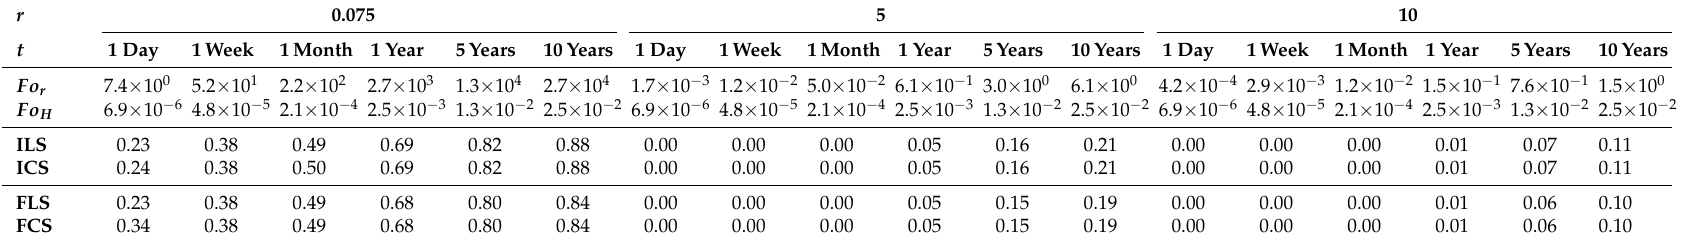
Table 3. Configuration #1: comparison among the Θ g values evaluated through different analytical models. r b = 0.075 m, H b = 100 m, R (cid:48) = 1/1330.